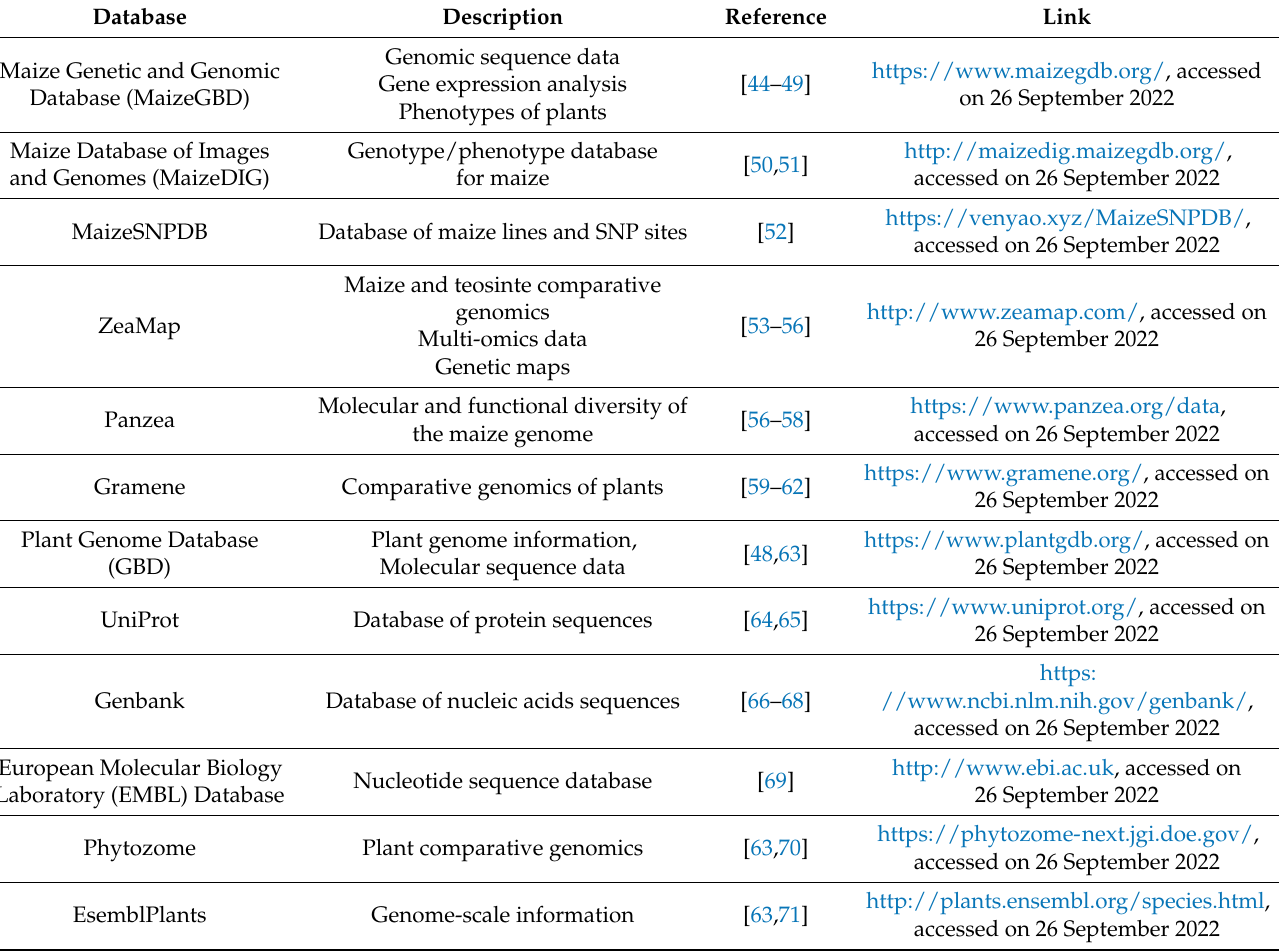
Table 1. Zea mays breeding-related biological datasets and bioinformatics